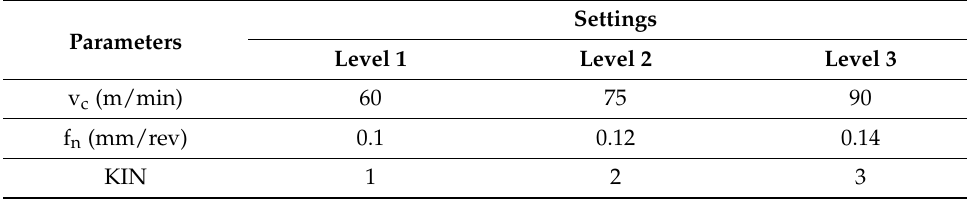
Table 3. Input parameters and the setting levels.